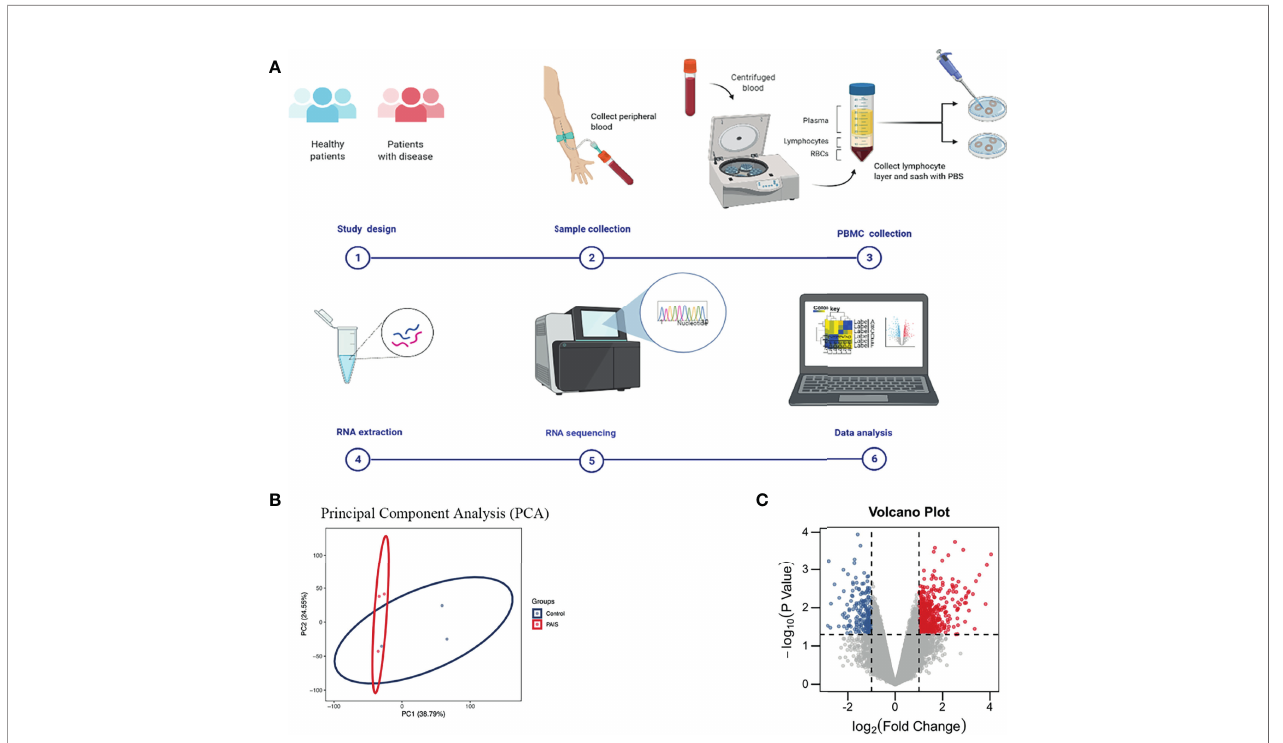
FIGURE 1 | Experiment process and principal component analysis (PCA) and volcano plot of differentially expressed genes (DEGs). (A) Schematic diagram of experiment procedure. (B) PCA of two groups. (C) DEGs in partial androgen insensitivity syndrome (PAIS) patients and healthy controls samples are shown in the volcano plot, with blue dots representing signi fi cantly downregulated genes and red dots representing signi fi cantly upregulated